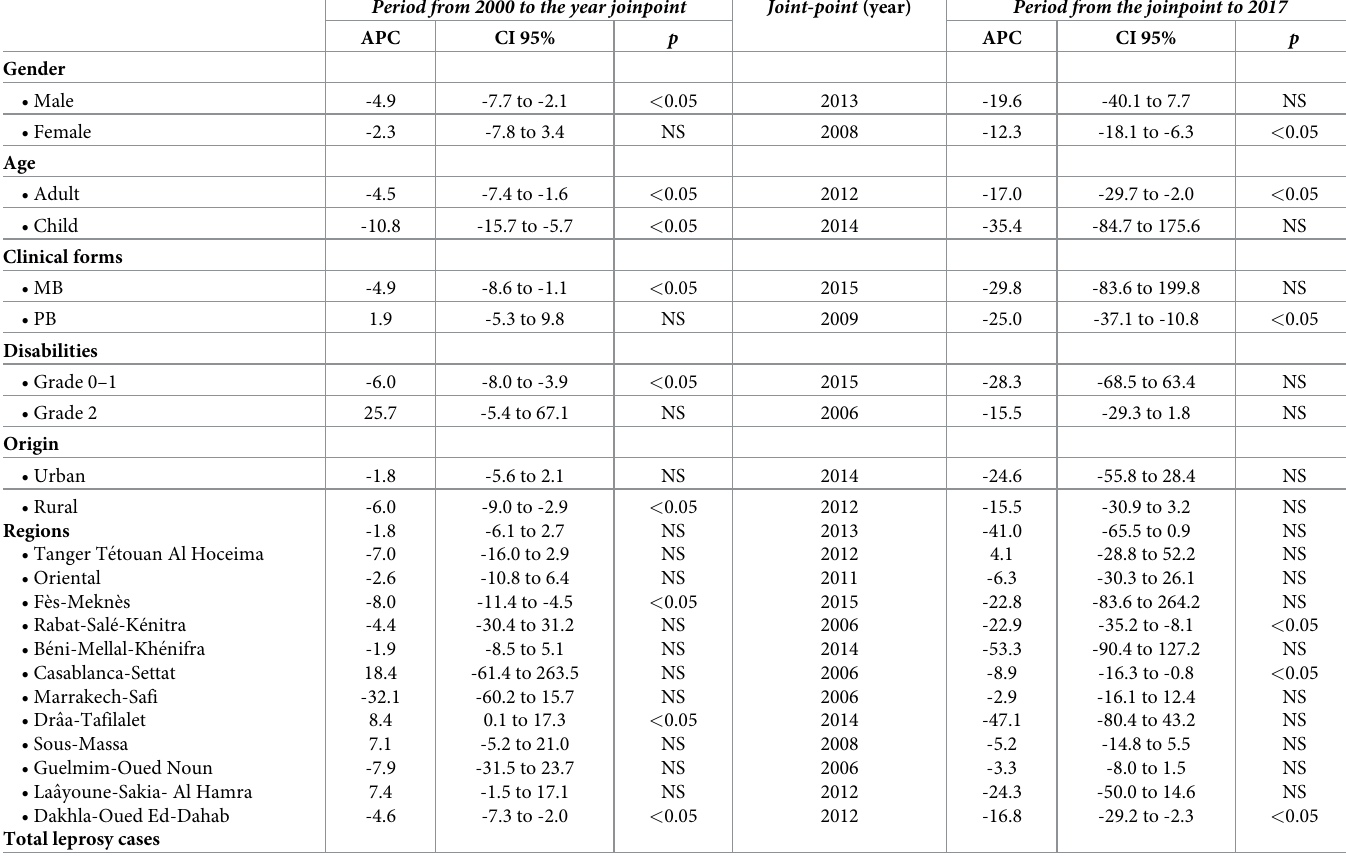
Table 2. Stratified joinpoint regression analysis for leprosy detection during the period 2000–2017. Period from 2000 to the year